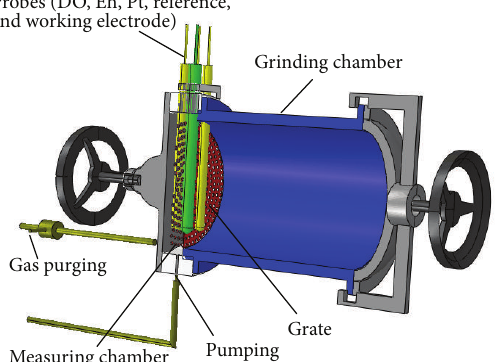
Figure 1: Schematic plan of specially designed ball